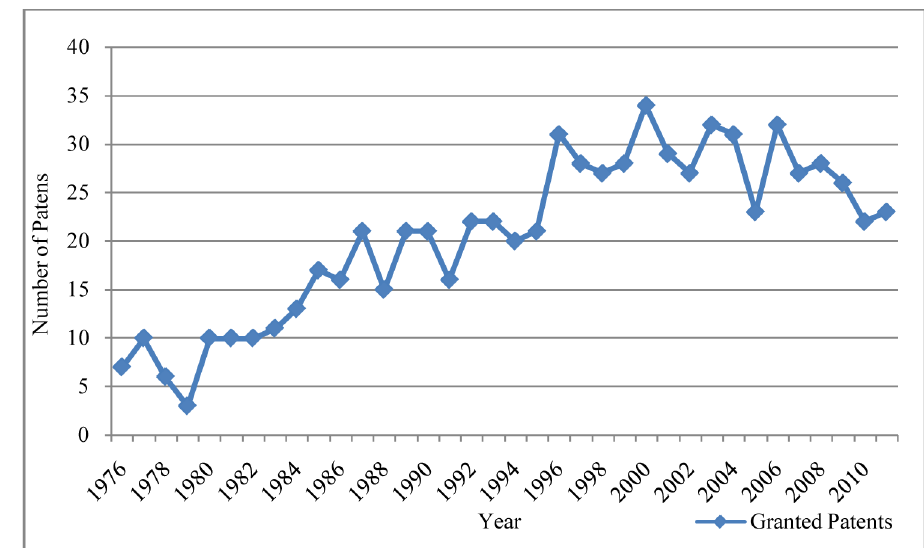
Fig. 3. Number of granted patents during the period 1974–2011